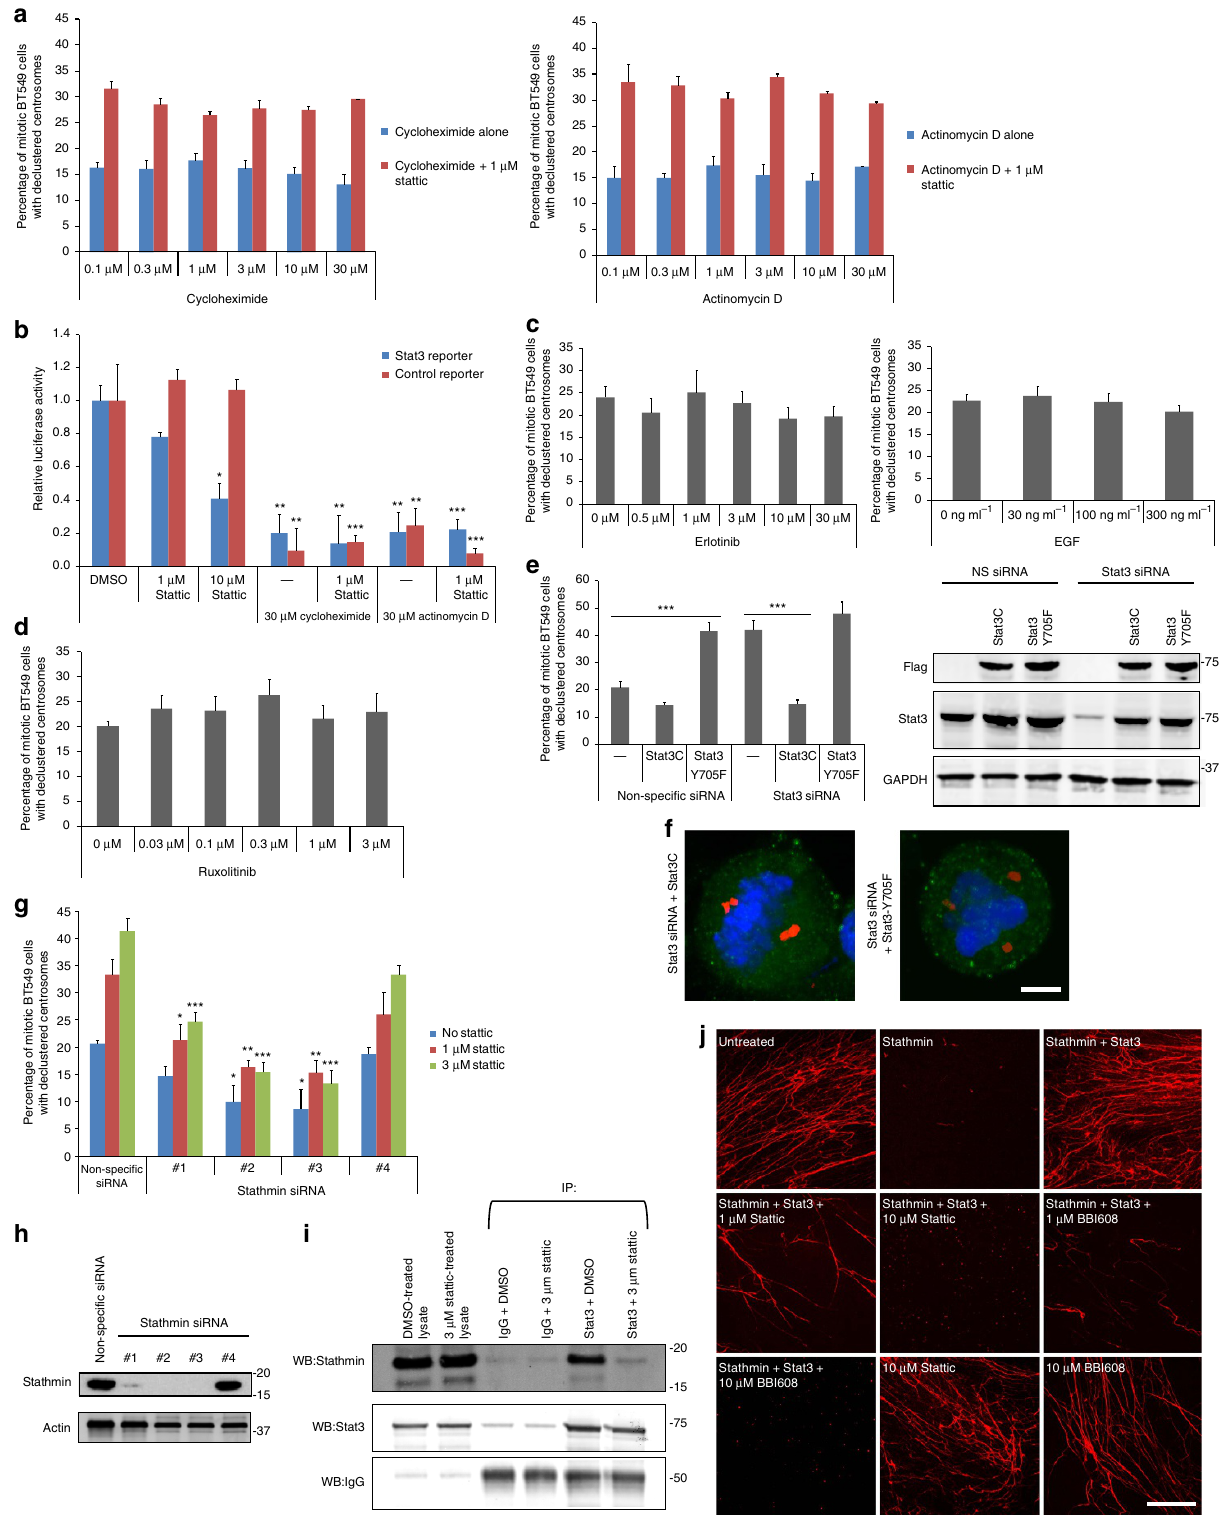
NATURE COMMUNICATIONS|8:15289|DOI: